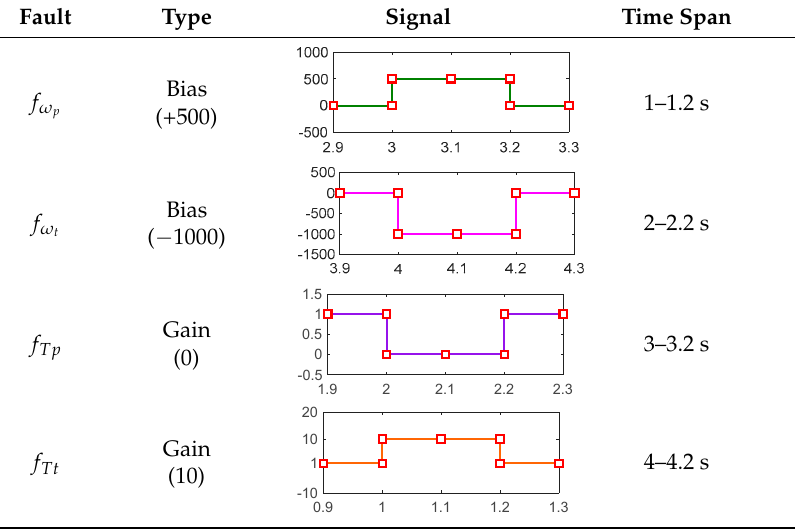
Table 7. Injected sensor fault settings of the HTC in a Honda CRV from Pohl’s experiment. Fault Type